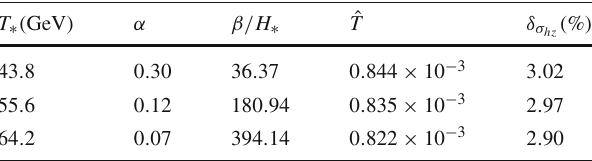
= δσ /σ sion δ σ √ hZ hZ . CEPC can achieve the precision hZ (cid:3) 1 . 6% at δ σ s = 240 GeV collision energy, hZ